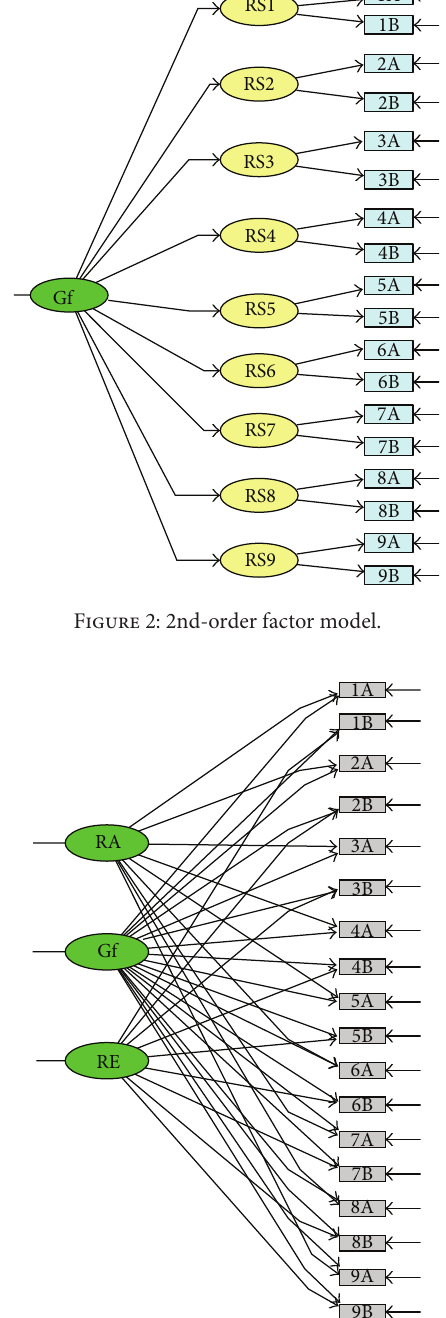
Table 1: Sociodemographic characteristics of the sample ( 𝑁 = 774